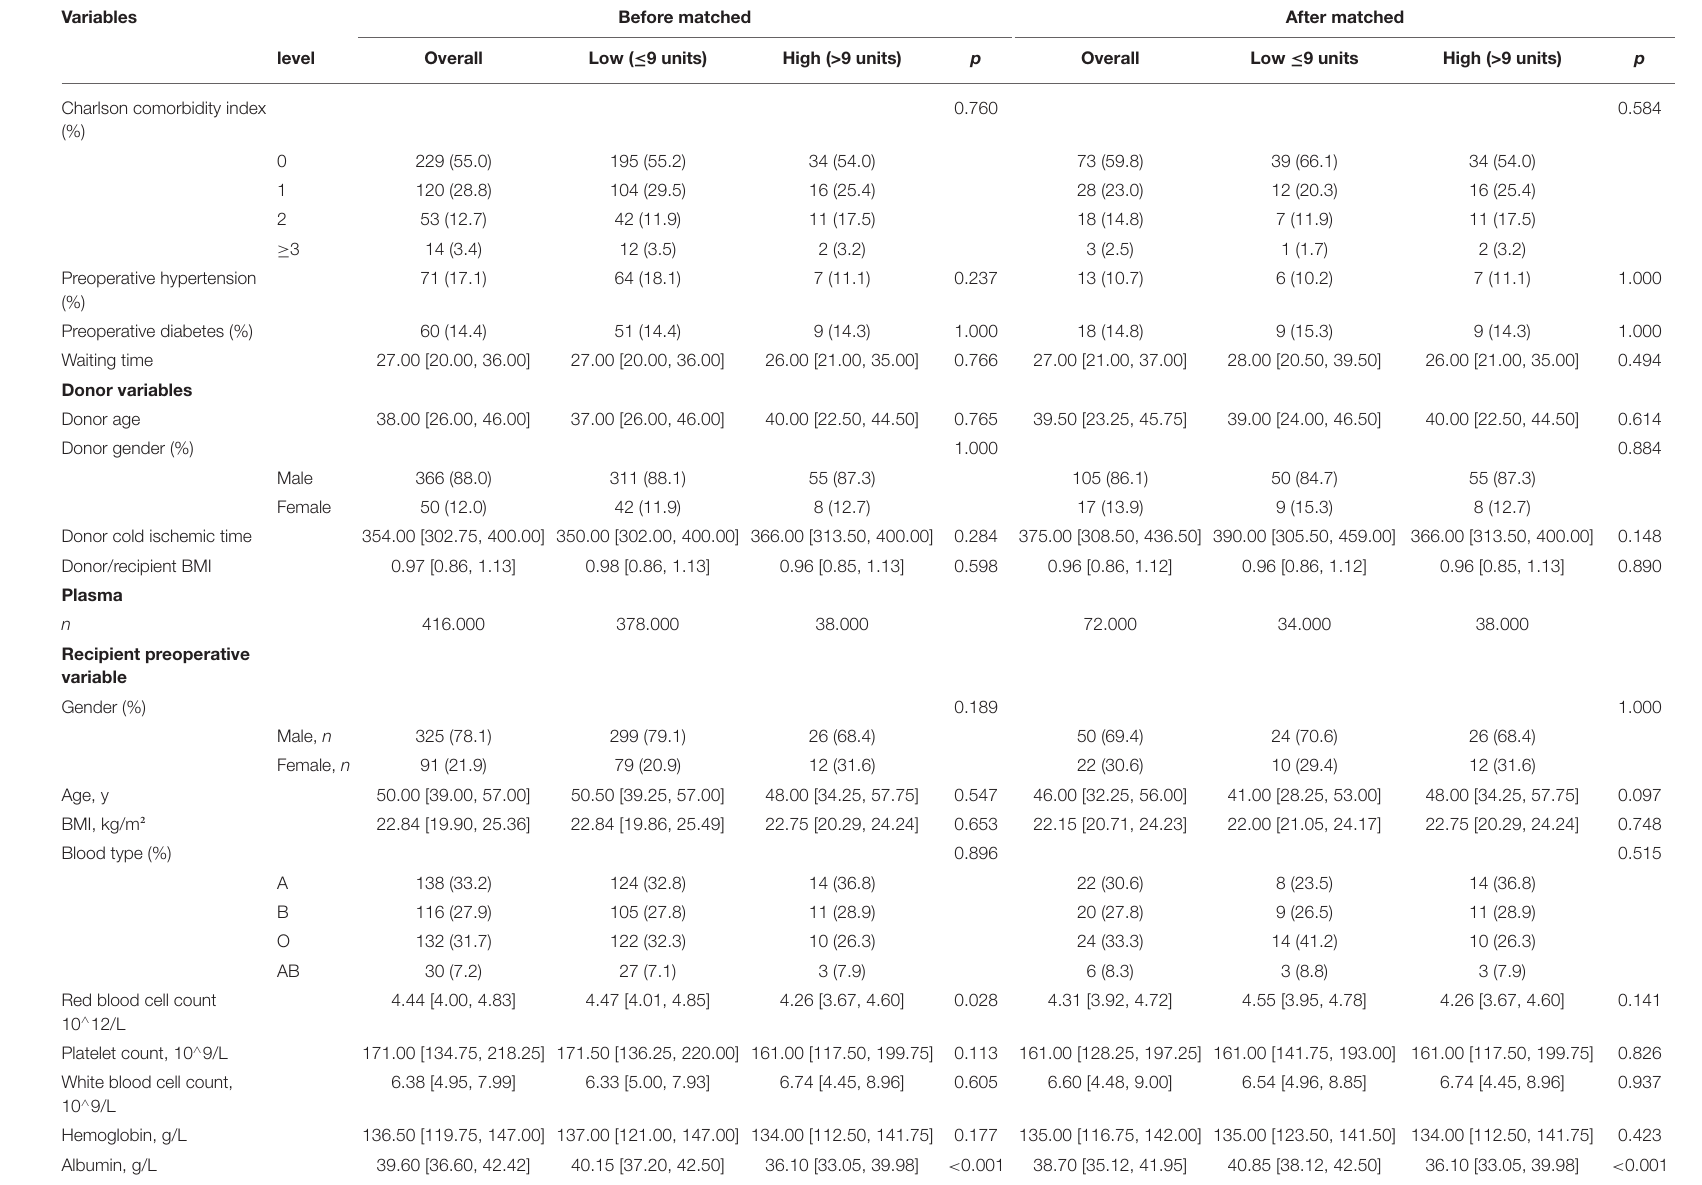
Platelet count, 10 ∧ 9/L White blood cell count, 10 ∧